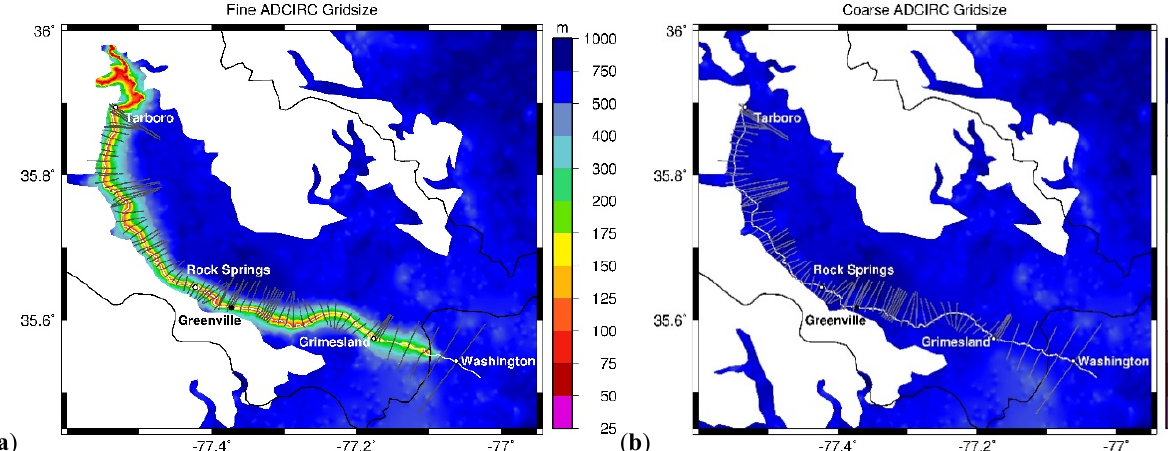
Figure 1. HEC-RAS model (gray cross-sections) for the Tar River Basin shown with the ( a ) ADCIRC fine and ( b ) ADCIRC coarse grid size contours (same scale for both in meters) and HL-RDHM watershed extents (black lines—stream network not shown). Note that the coastline is not shown because it is downstream from Washington, NC, although the river is still tidally influenced at this